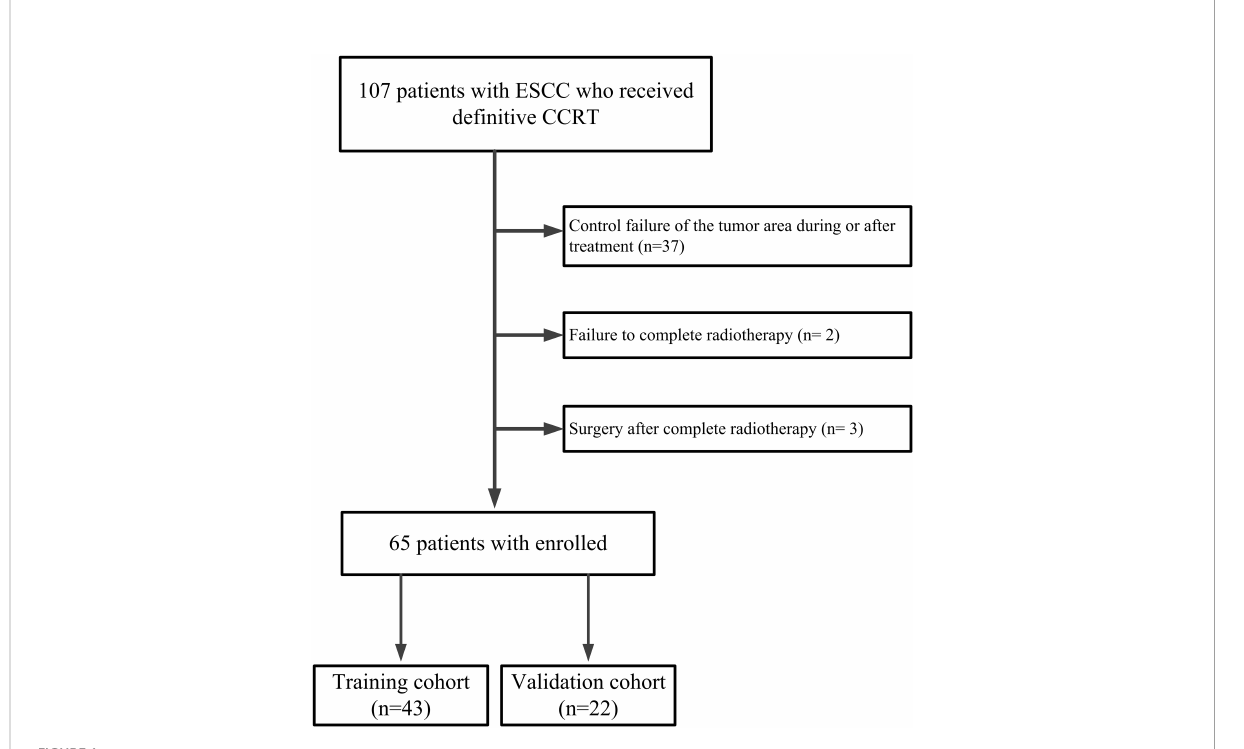
FIGURE 1 The work fl ow of Inclusion and